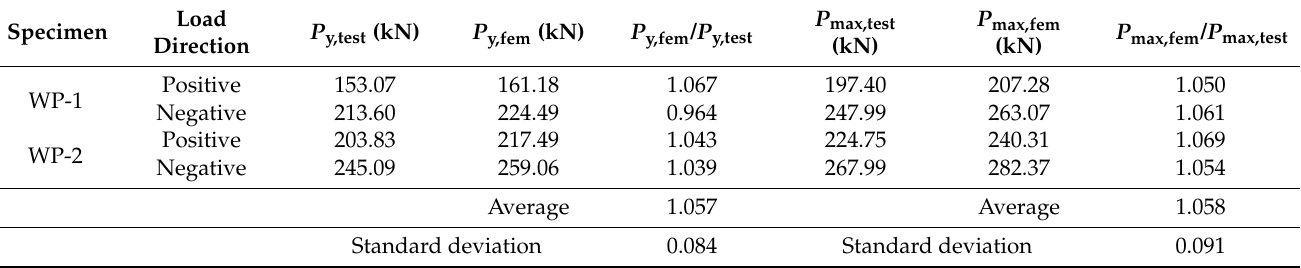
Table 5. Load capacity comparison between the test and the FE model.